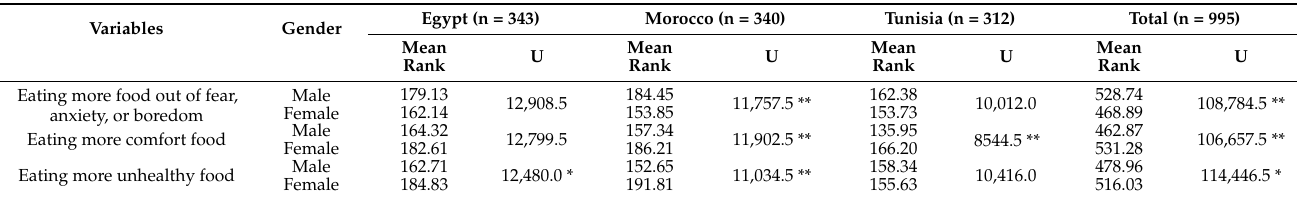
Table 3. Effects of gender on some food-related